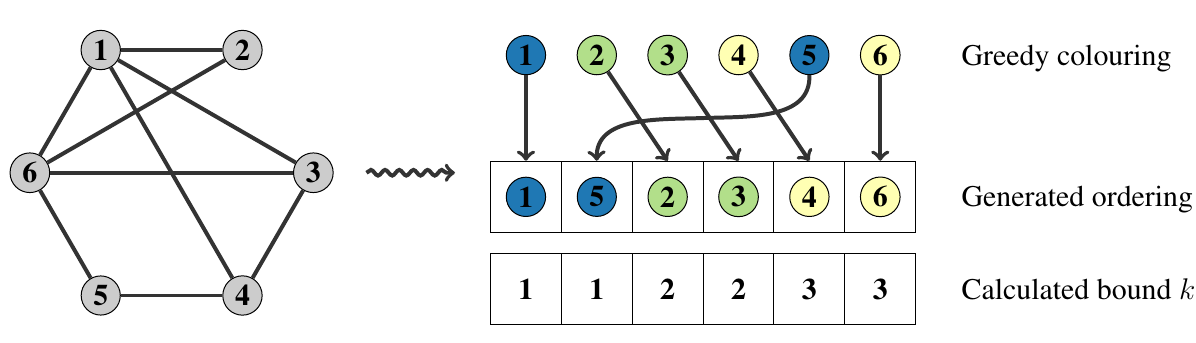
Figure 1. A small graph, together with a constructive colouring.